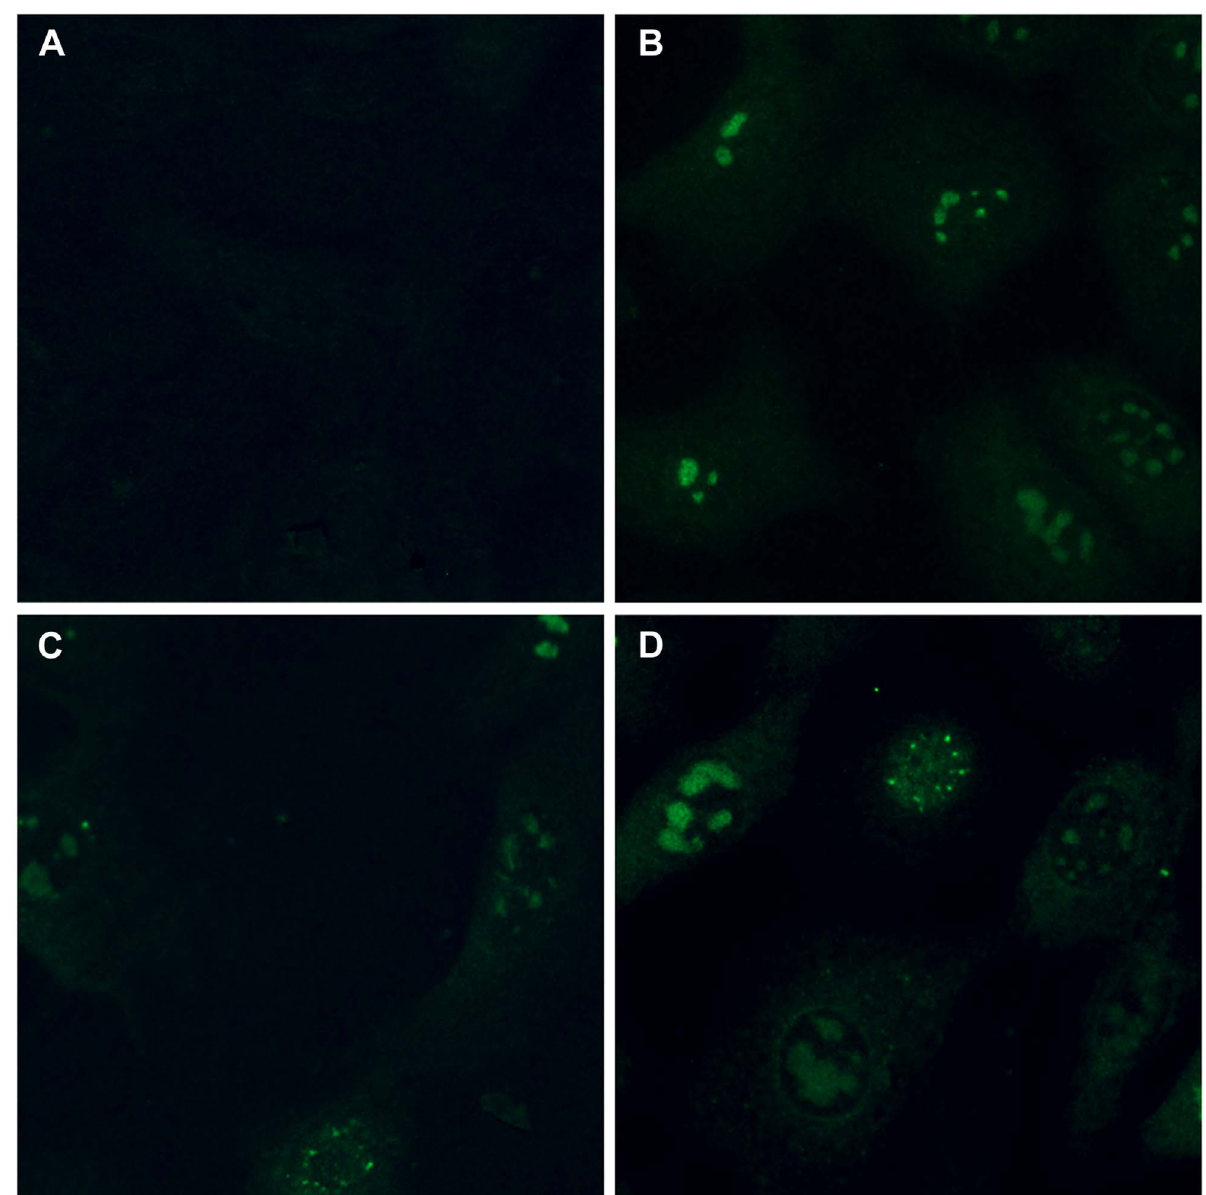
Figure 2. Subcellular distribution of ICP4 in ICP4-expressing cells infected with wild type or d 120 virus. HSV-1 d 120 (ICP4-null) (A, C) or KOS (B, D) was added to Vero (A, B) or E5 (ICP4-expressing) (C, D) cell monolayers at an MOI of 5. At 6 hr post-infection, cells were fixed, and ICP4 was detected with MAb H1A021 followed by fluorescent secondary antibody. Results shown are representative of at least three independent experiments with each condition tested in triplicate. Magnification, 40 6